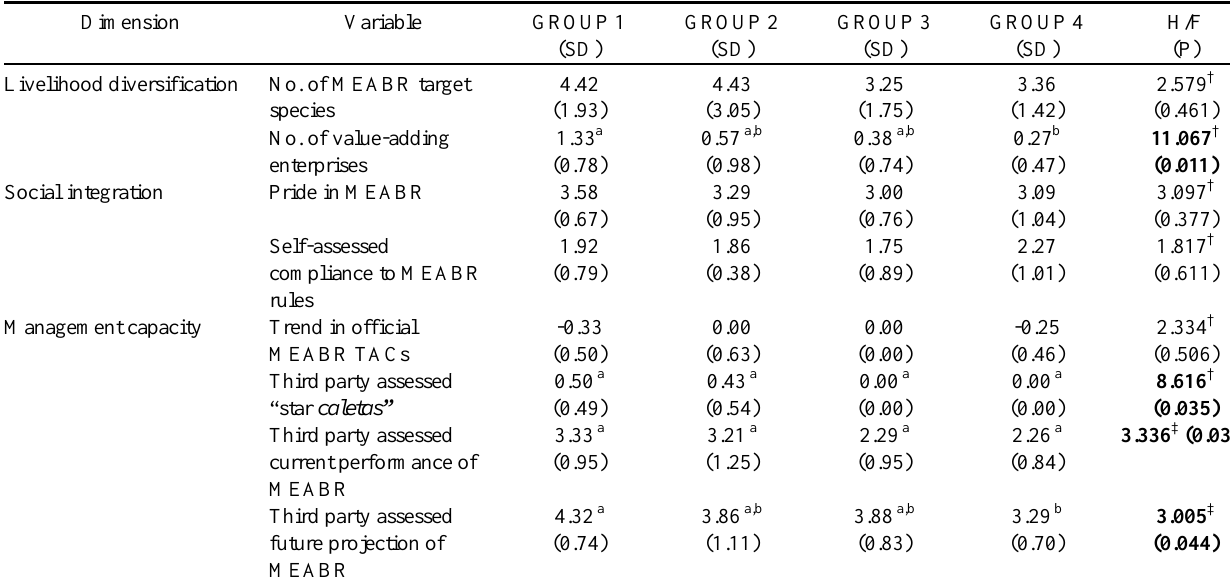
Table 4 . Comanagement performance variables within social capital groups. MEABR = Management and Exploitation Areas for Benthic